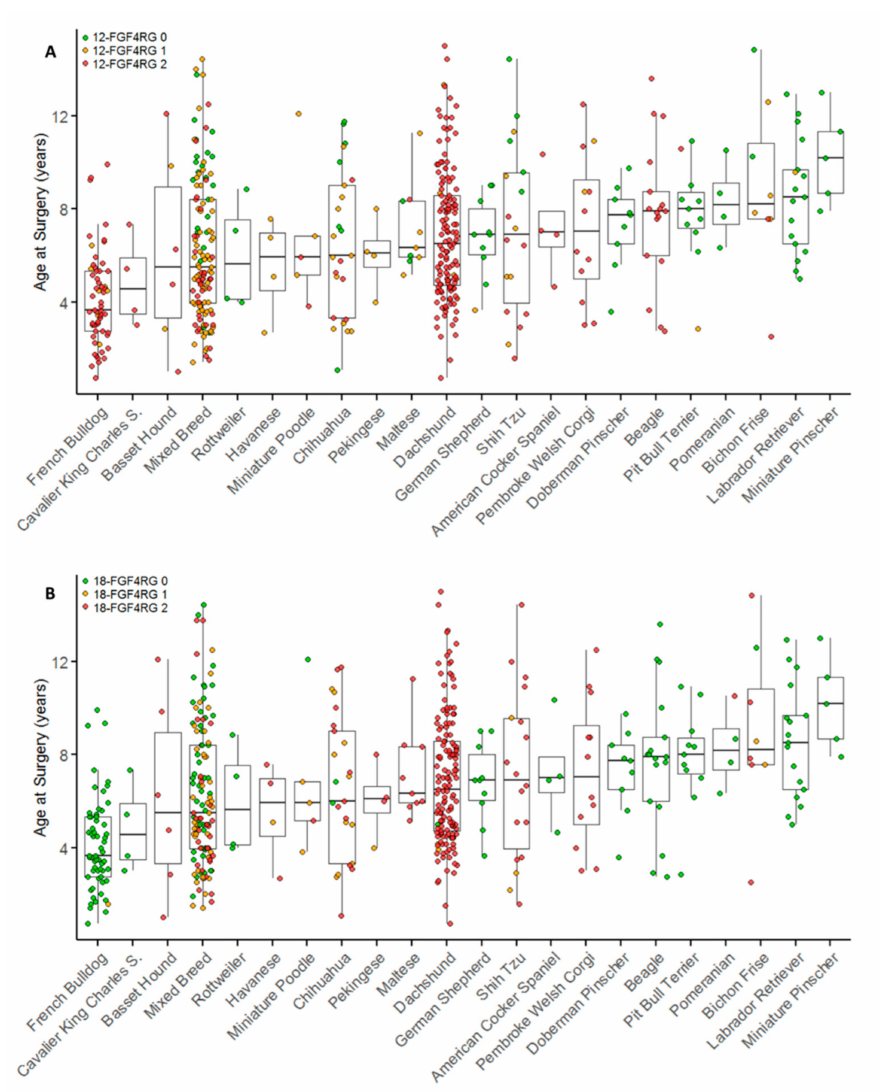
Figure 2. Breed and genotype distribution of surgical IVDD cases by age at surgery. Breeds are plotted in order of ascending median age at surgery. Individuals are colored by 12- FGF4 RG genotype ( A ) and 18- FGF4 RG genotype ( B ). Breeds with fewer than four cases are not included ( n = 510). Red indicates two copies of each retrogene, orange indicates one copy, and green indicates zero